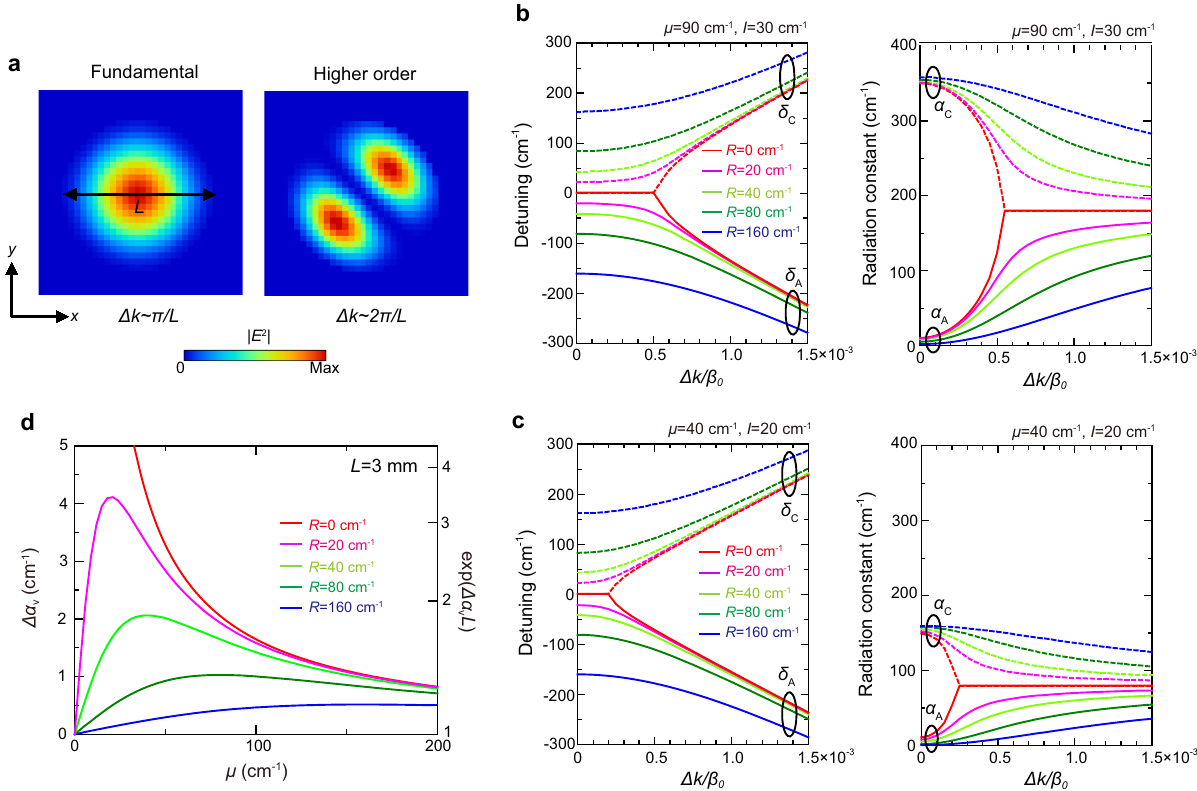
Fig. 4 Radiation constant difference in fi nite-size PCSELs. a Typical electric fi eld distributions of the fundamental and higher-order modes in a fi nite-sized device with a diameter of L . b , c Calculated frequencies and radiation constants of modes A and C as functions of Δ k for several values of R , where the other parameters ( μ and I ) are fi xed to constant values ( μ = 90 cm − 1 , I = 30 cm − 1 in Fig. 4b and μ = 40 cm − 1 , I = 20 cm − 1 in Fig. 4c). d Threshold margin ( Δα v and e Δα v (cid:8) L ) for a 3-mm-diameter PCSEL when the values of R and μ are